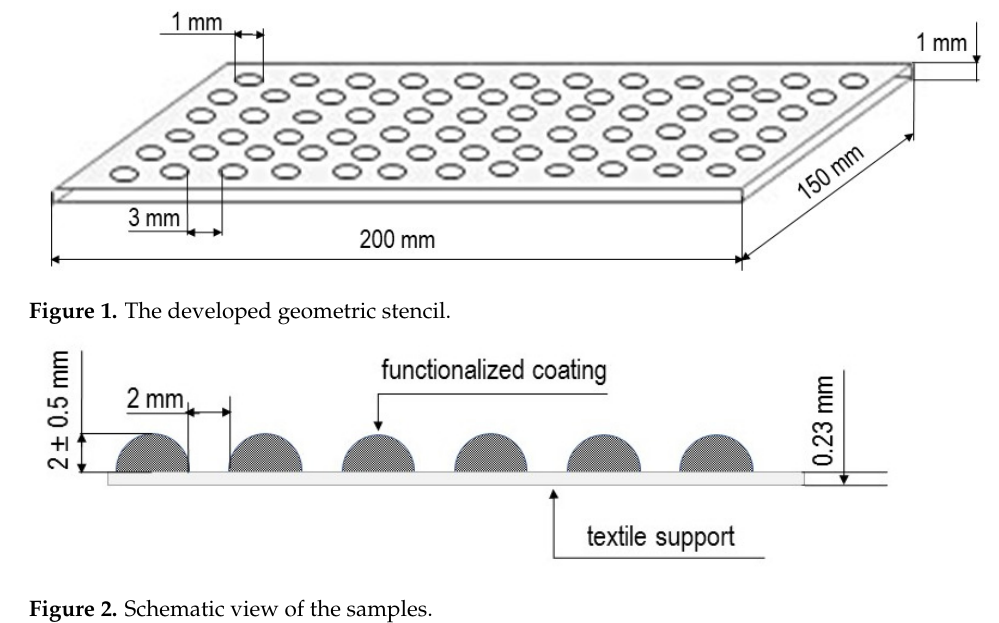
Table 2. Performance levels for cut resistance [3].